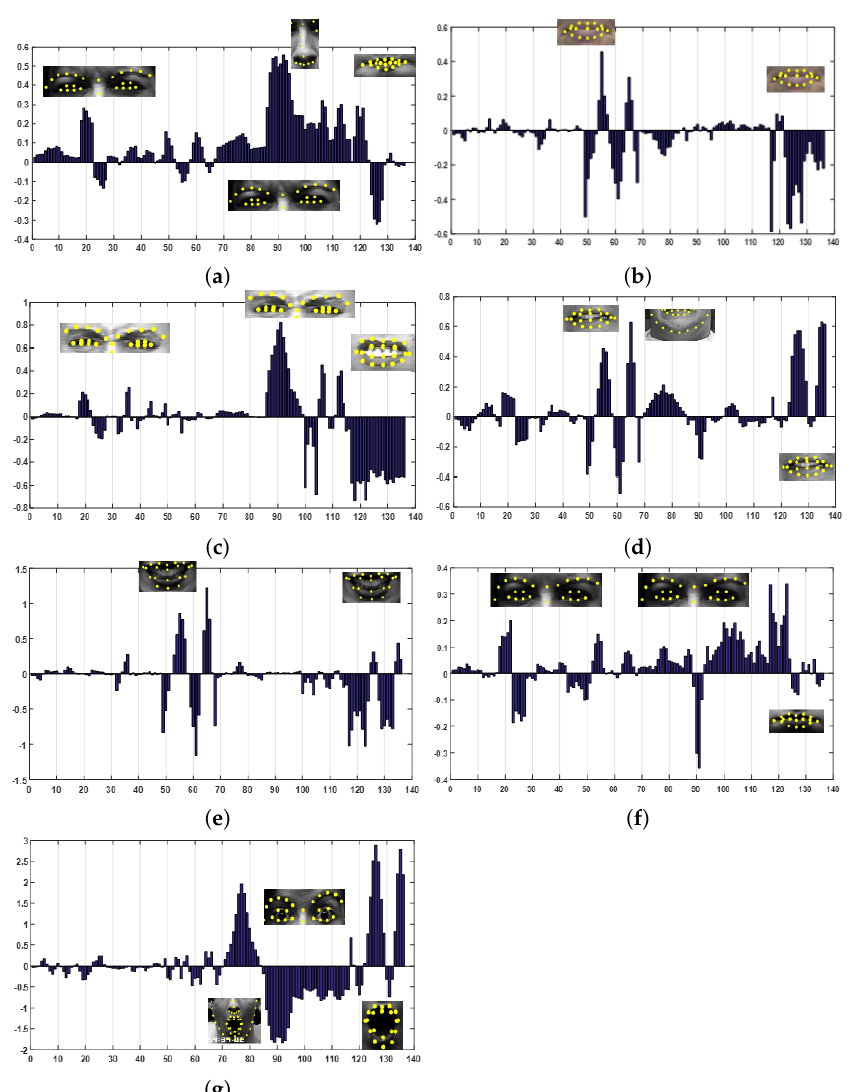
Figure 5. Average landmark flow in different expressions: ( a ) Anger, ( b ) Contempt, ( c ) Disgust, ( d ) Fear, ( e ) Happiness, ( f ) Sadness, ( g ) Surprise. Blue line shows average intensity in each landmark point. Yellow dot shows the landmark flow in the image